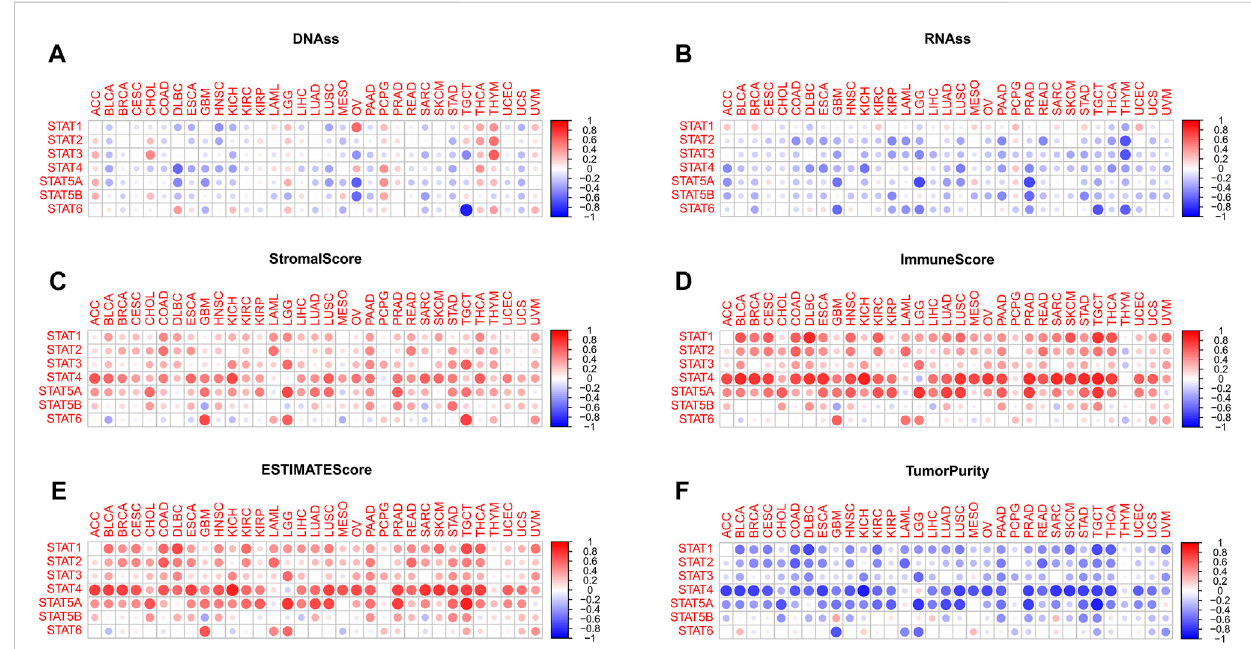
FIGURE 5 Tumor stemness and tumor purity analyses of STATs in pan-cancer. (A) Heatmap revealing the correlations between expression levels of STAT1, STAT2, STAT3, STAT4, STAT5A, STAT5B and STAT6 and mDNAss in 33 TCGA tumor types. (B) Heatmap showling the correlations between expression levels of STAT1, STAT2, STAT3, STAT4, STAT5A, STAT5B and STAT6 and mRNAss in 33 TCGA tumor types. (C) Heatmap demonstrating the correlations between expression levels of STAT1, STAT2, STAT3, STAT4, STAT5A, STAT5B and STAT6 and stromal score. (D) Heatmap demonstrating the correlations betweenexpression levels ofSTAT1, STAT2, STAT3,STAT4, STAT5A, STAT5B, and STAT6 and immune score. (E) Heatmap demonstrating the correlations between expression levels of STAT1, STAT2, STAT3, STAT4, STAT5A, STAT5B, and STAT6 and ESTIMATE score. (F) Heatmap demonstrating the correlations between expression levels of STAT1, STAT2, STAT3, STAT4, STAT5A, STAT5B and STAT6 and tumor purity. (mDNAss: DNA methylation- based stemness score; mRNAss: mRNA-based stemness